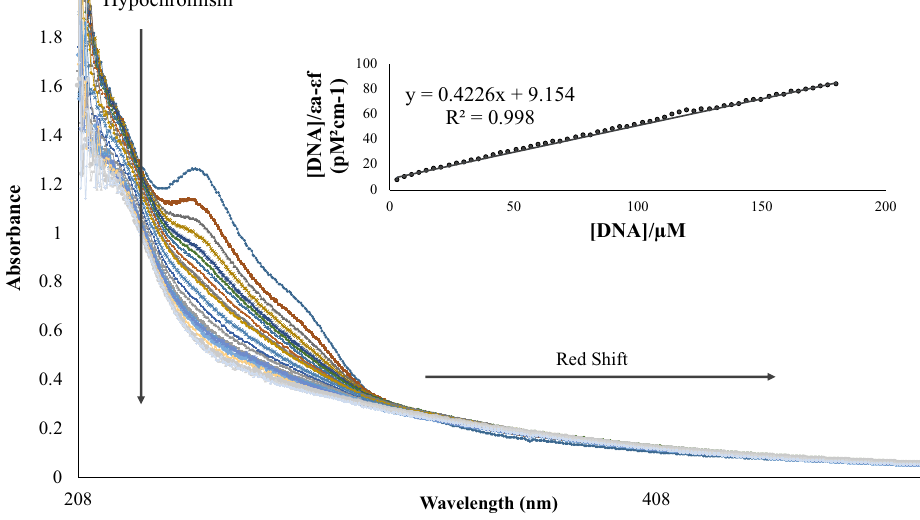
Figure 4. Absorption spectral changes of HexaFc complex (30 μM) in Tris-HCl buffer (pH 7.1) in the absence and presence of increasing concentrations of CT-DNA. Inset: fitting of the absorbance data that were used to obtain the binding constant at 250